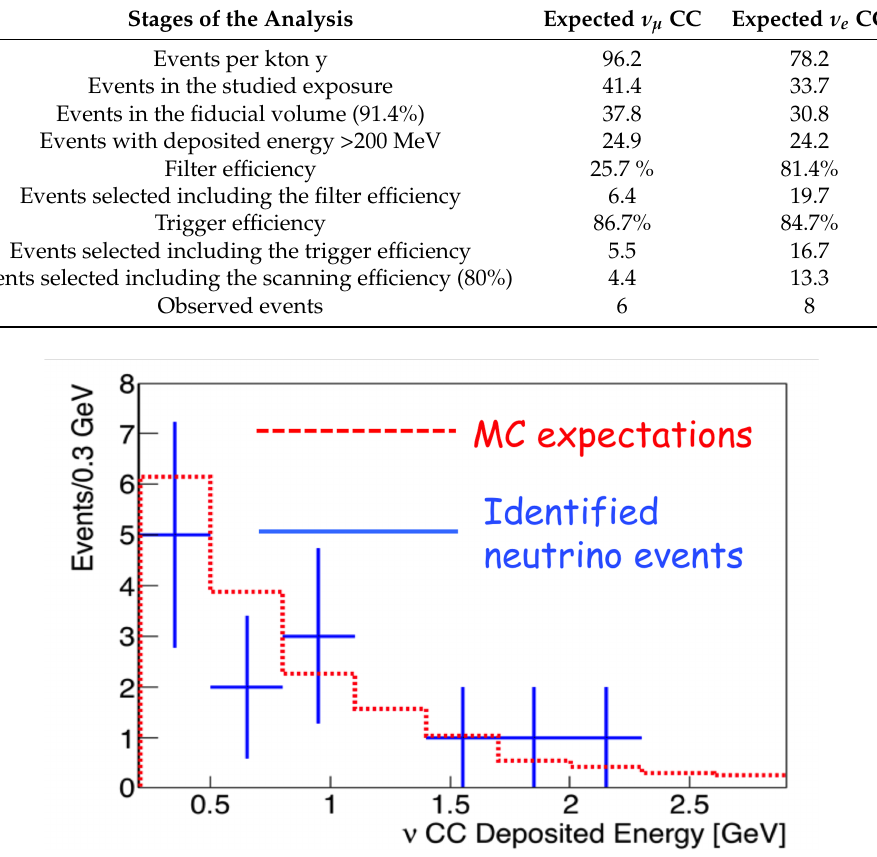
Figure 5. Zoom of the deposited energy distribution of the identified atmospheric neutrino events, compared with the expected distribution from MC